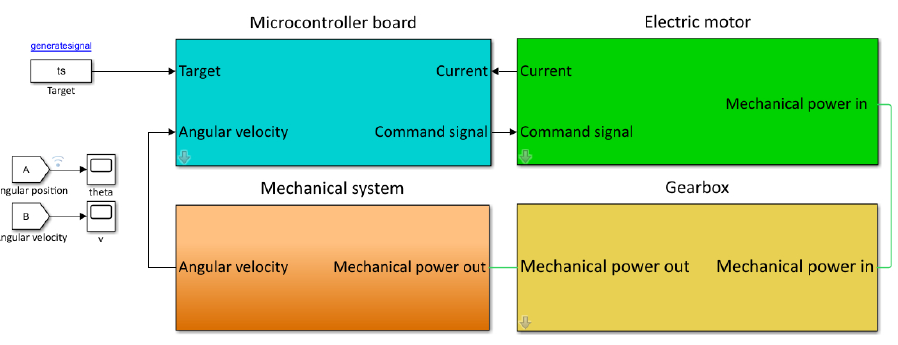
Figure 16. Simscape model of the mechatronic interface.